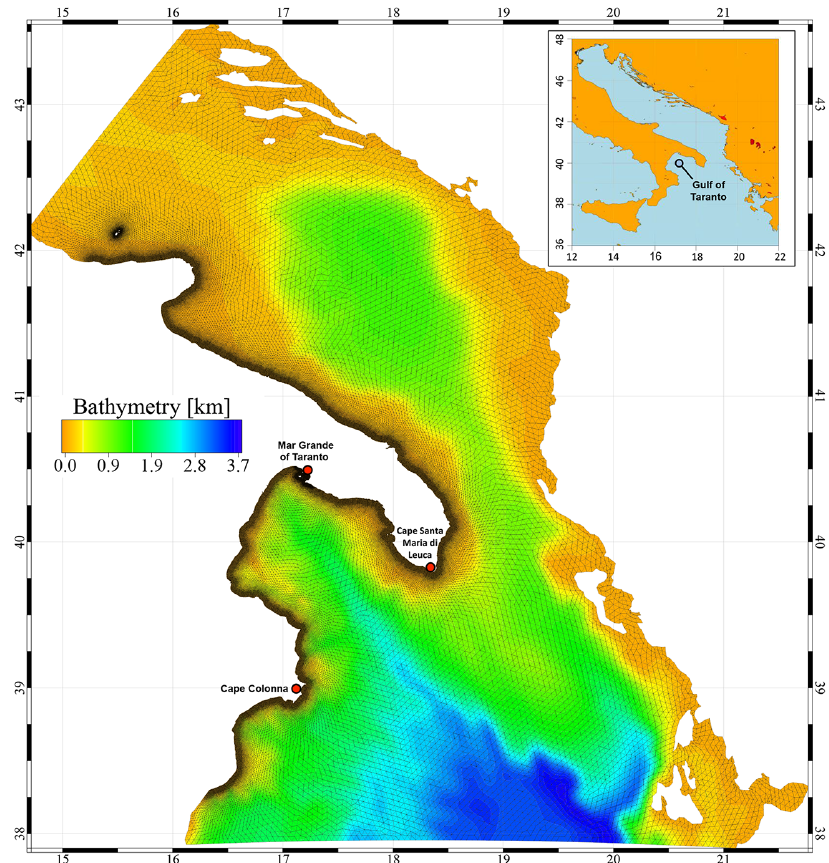
Figure 1. SANIFS domain: horizontal grid overlapped on bathymetry for the whole